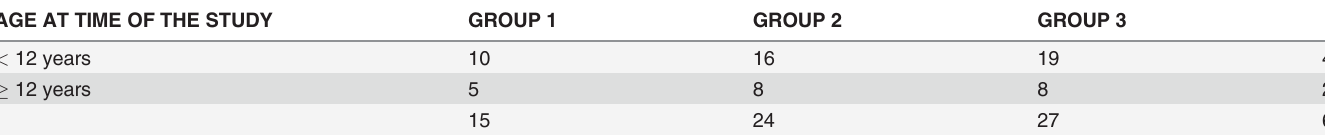
Table 3. Children's age at time of the study (according to group). AGE AT TIME OF THE STUDY